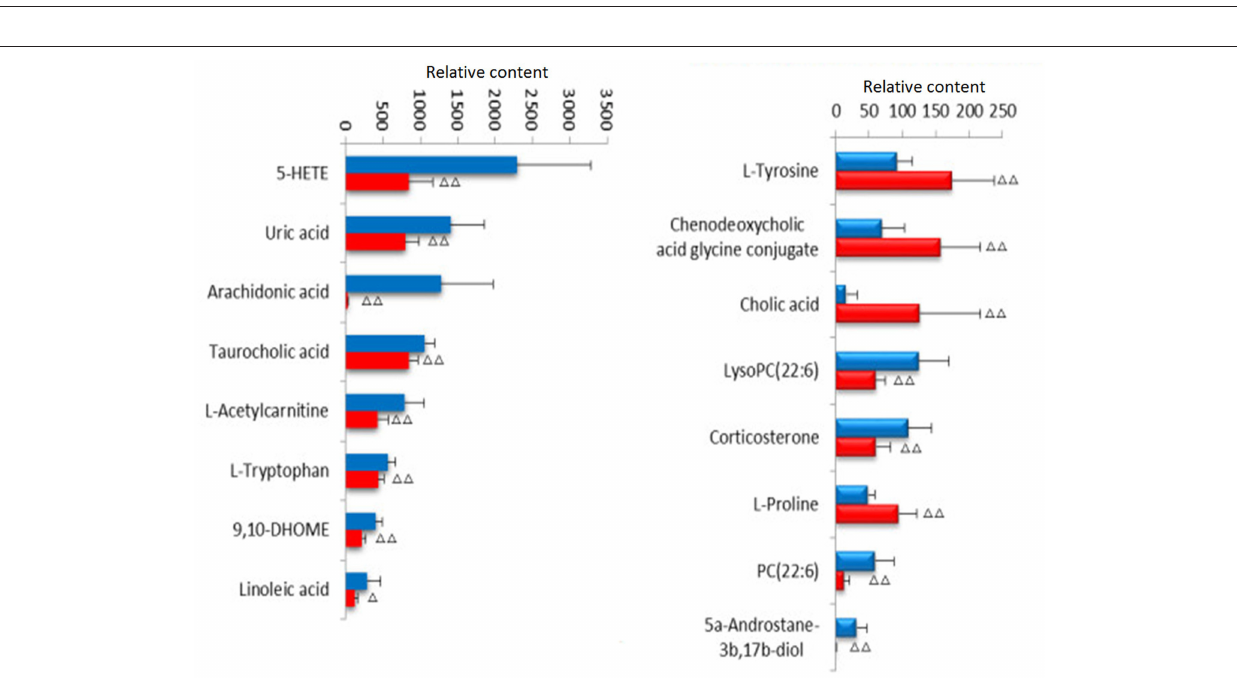
FIGURE 7 | Changes of potential biomarkers in ovariectomized osteoporosis model. , Sham operation group; , OVX Model group. Compare with sham operation, 1 P < 0.05, 11 P < 0.01.